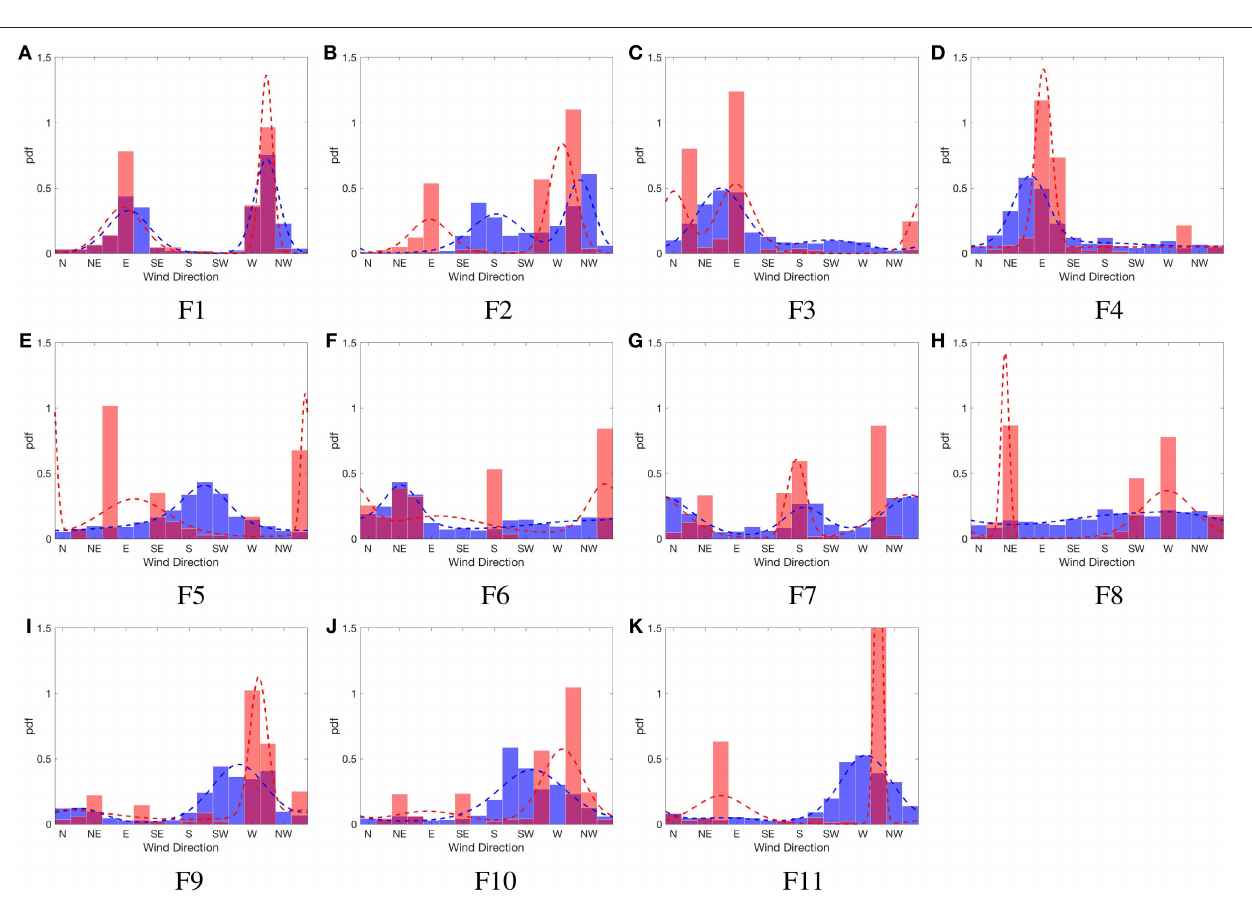
FIGURE 8 | Observed (blue) and predicted (red, using momentum solver) unconditional wind direction distributions at sites (A–K) F1 to F11, across Flea Creek Valley. Dotted lines indicate fitted 2-component mixture von Mises distributions with parameters given in Table 6 .